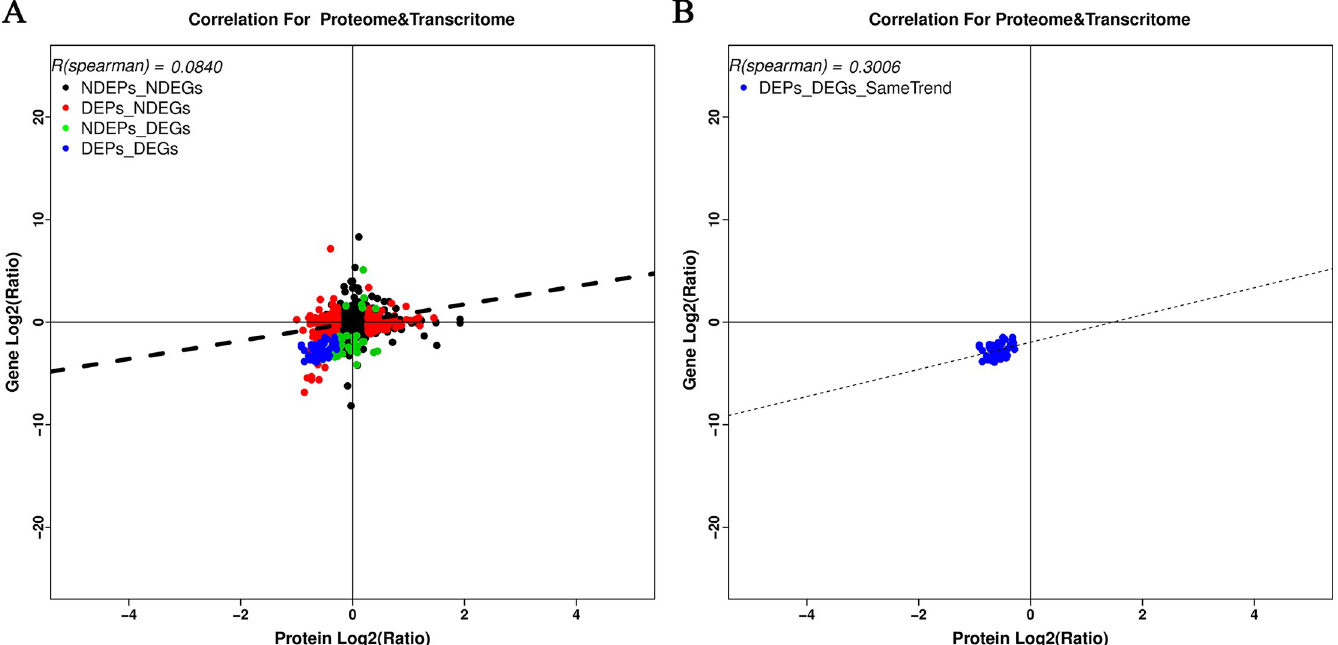
Fig 6. Correlations between the expression of proteins and genes. The vertical-axis represents the protein expression level, and the horizontal-axis represents the genes expression level. (A) Scatter plots of the correlation between data sets of genes evaluated in both the proteomic and gene transcript analyses. (B) Scatter plots and coefficients of DEPs and DEGs